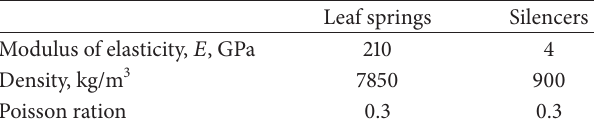
Table 1: Materials and properties of leaf springs and silencers. Leaf springs